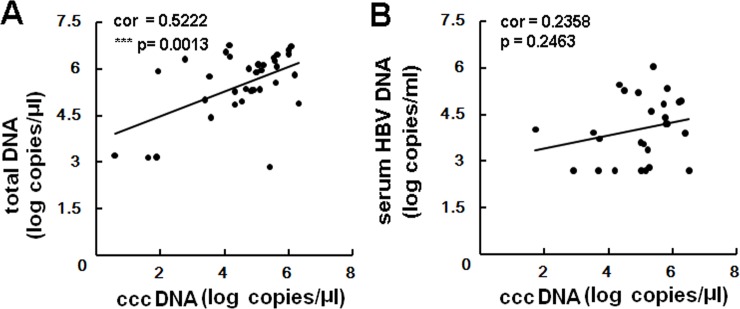
Correlation between intrahepatic HBV cccDNA and HBV total DNA or serum HBV DNA.A significant correlation was observed between total intrahepatic cccDNA levels and HBV DNA (panel A), but not for serum HBV DNA level (panel B) among 35 HCC patients with detectable cccDNA in paired samples.